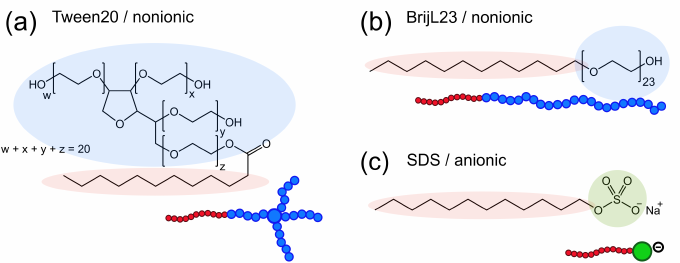
Figure 1. The molecular structures and schematic drawings of the surfactants used in this study: ( a ) nonionic Tween20, ( b ) nonionic BrijL23, and ( c ) anionic SDS. The hydrophobic alkyl chains are highlighted in red. The hydrophilic headgroups are highlighted in blue and green for nonionic polyethyleneoxide (PEO) groups and the anionic sulfate group, respectively.